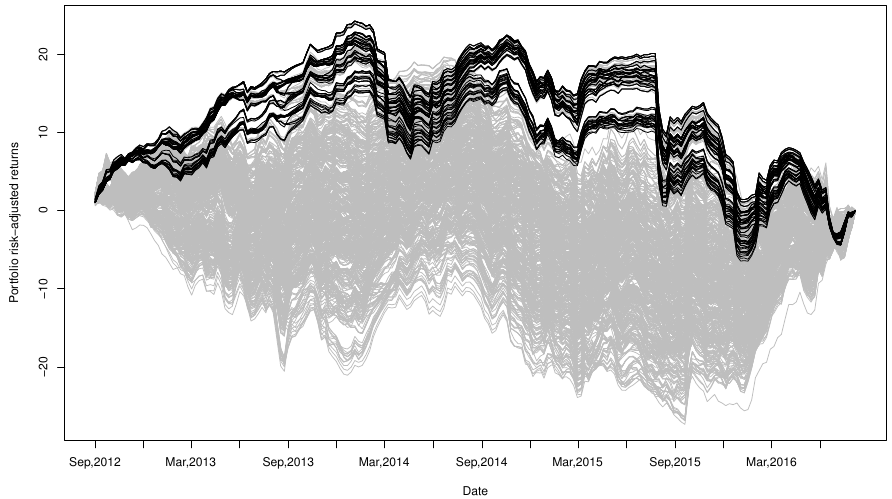
Figure 13. Risk-adjusted returns ( black lines ) of the 72 minimum variance portfolios selected based on our proposed clustering procedure, compared to risk-adjusted returns ( gray lines ) of minimum variance portfolios constructed by all combinations (1001 in total) of four currencies out of total 14